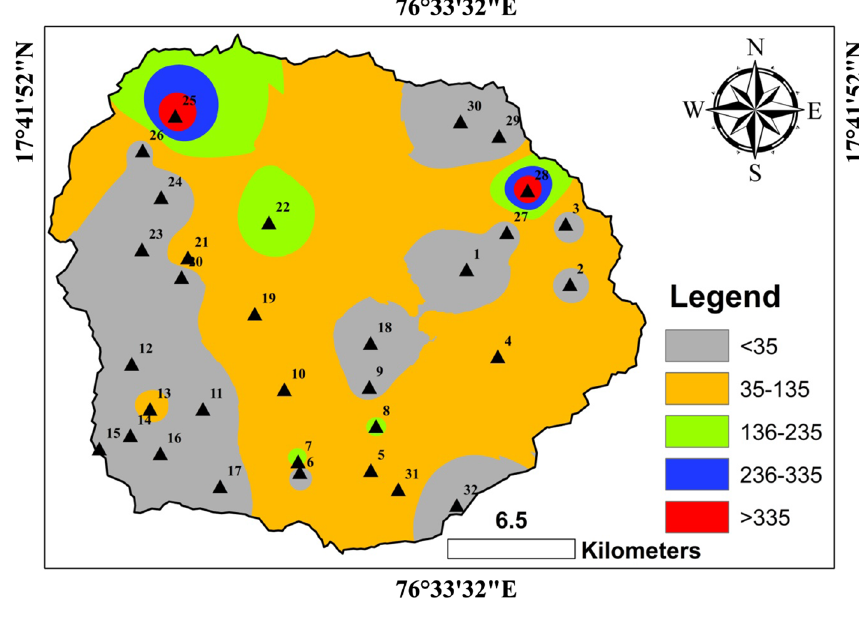
Fig. 23 Geospatial distribution of chloride